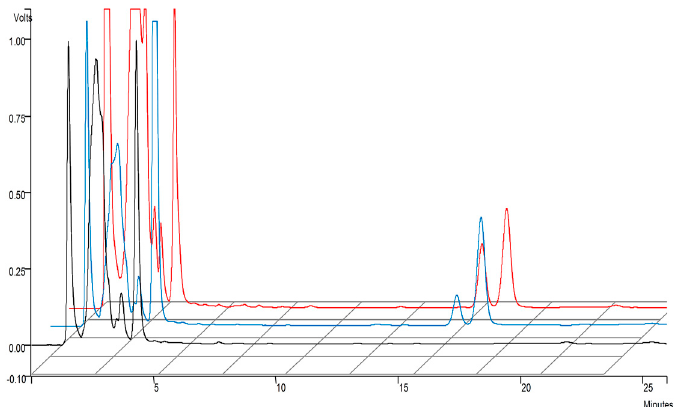
Figure 3. HPLC-FL chromatograms of a blank sample (black), a standard sphinganine sample (blue) and cell lysate sample after incubation (red).